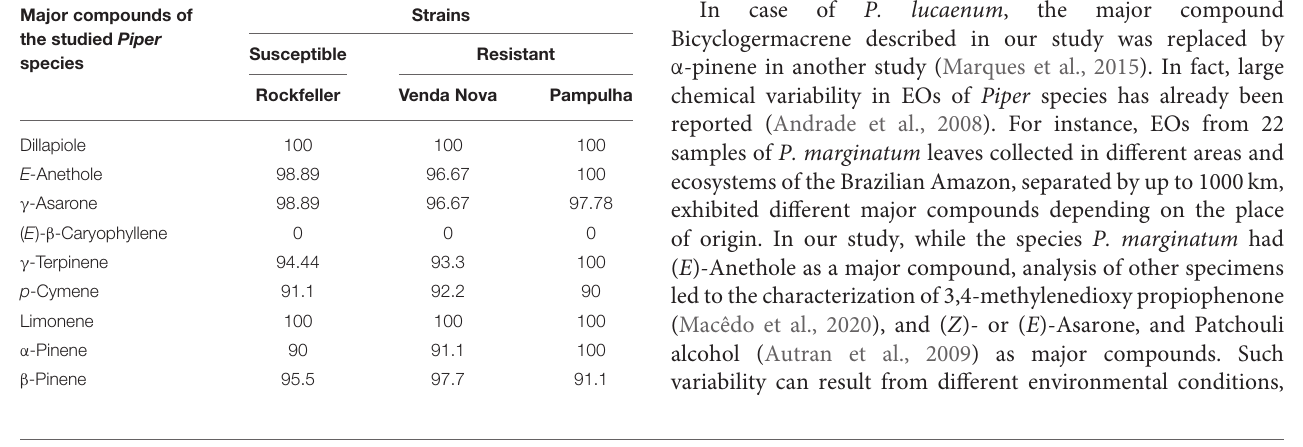
TABLE 8 | Evaluation of lethal concentrations of major compounds in Aedes aegypti larvae of resistant and susceptible strains to pyrethroids during 24h exposure to major compounds of Piper species.